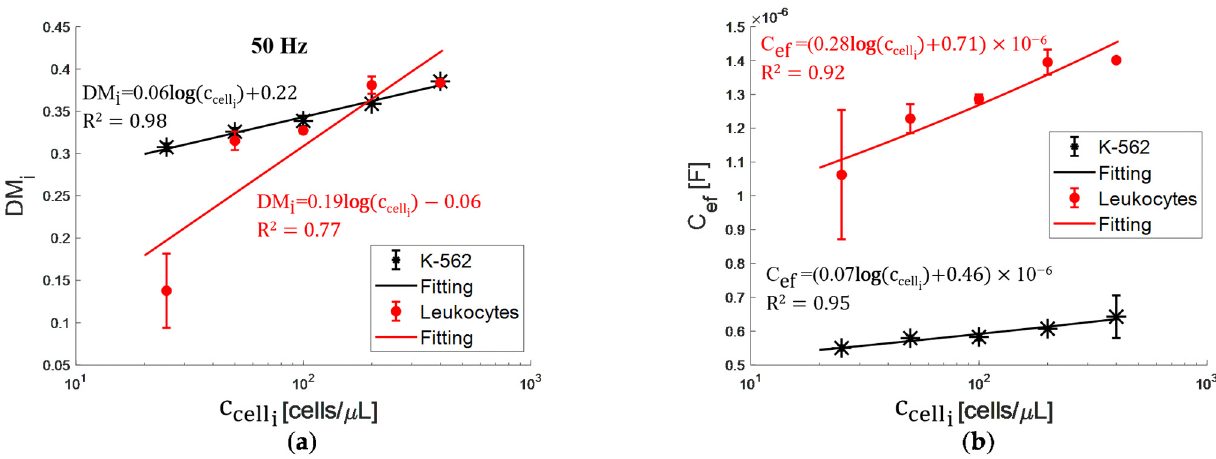
Figure 7. ( a ) DM i at 50 Hz and ( b ) C ef as a function of cell concentration (symbols-data and solid lines-fittings).